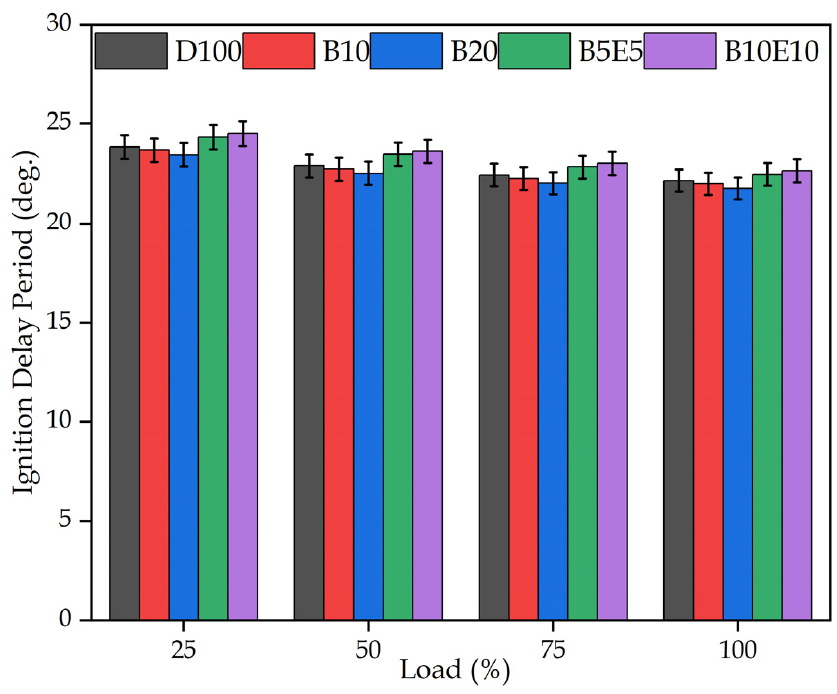
Figure 6. Ignition delay of different fuels against engine load.